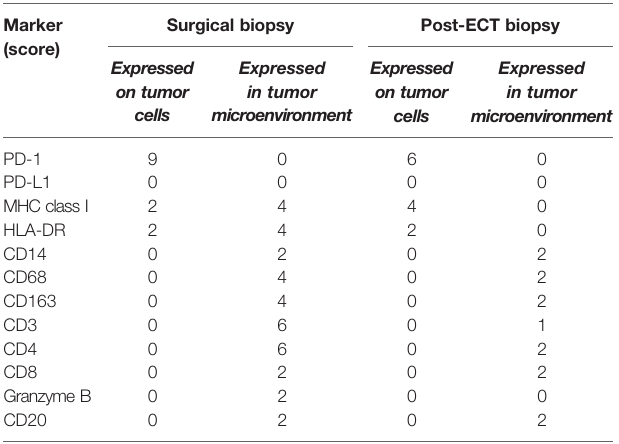
TABLE 2 | Expression of in fl ammatory markers using a semiquantitative scoring system that considers staining intensity (I) on a three-tiered scale (1, less intense than control; 2, intensity superimposable to control according to manufacturer indications; 3, more intense than control), as well as extension (E), de fi ned as the percentage of positive cells for each marker (0, 0%; 1, <25%; 2, 25 – 50%; 3, 51 – 74%; 4, 75 – 100%) (10). Total score = I